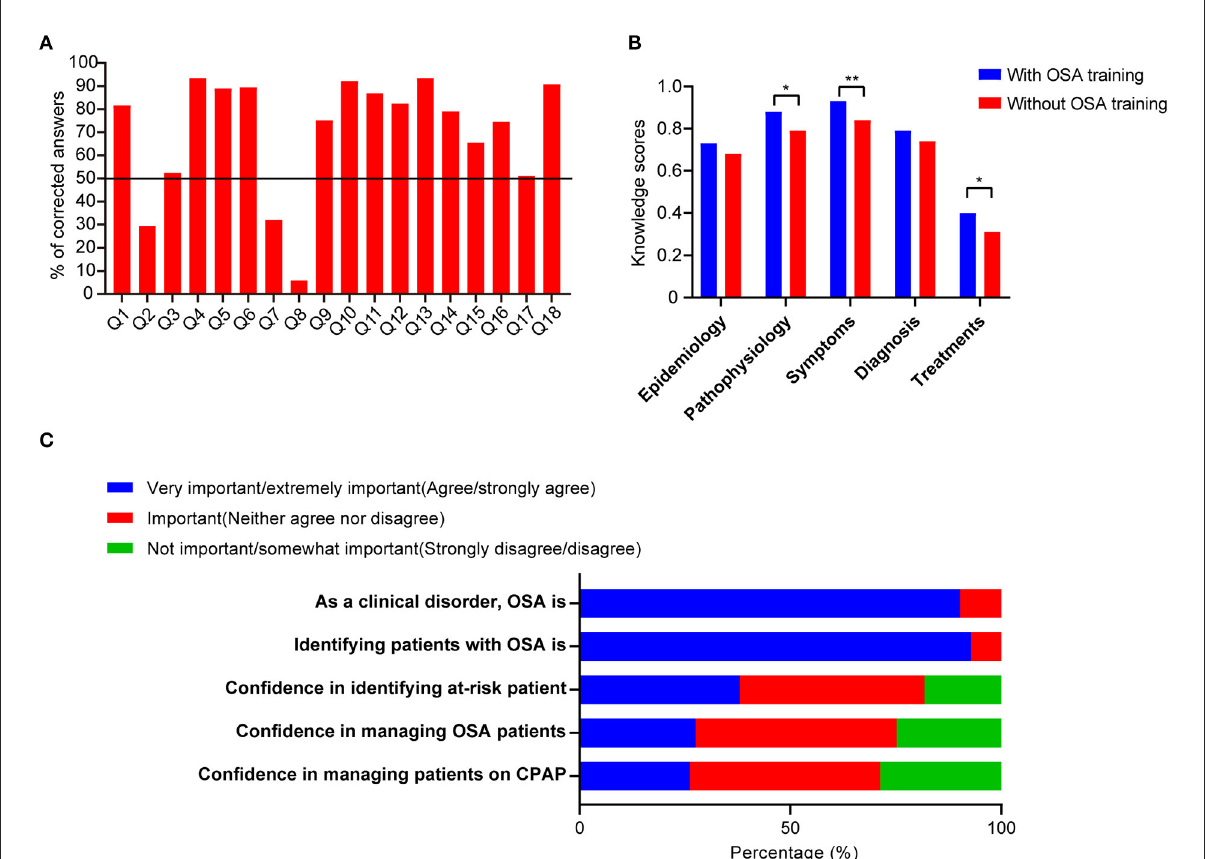
FIGURE1 Results of knowledge and attitude scores. (A) Percentage of corrected answers among the knowledge items. (B) The bar graph demonstrated a comparison of knowledge scores related to different characteristics among residents who had OSA training education or not. (C) Comparison of the composition of the responses in the attitude scores. * p < 0.05, ** p <